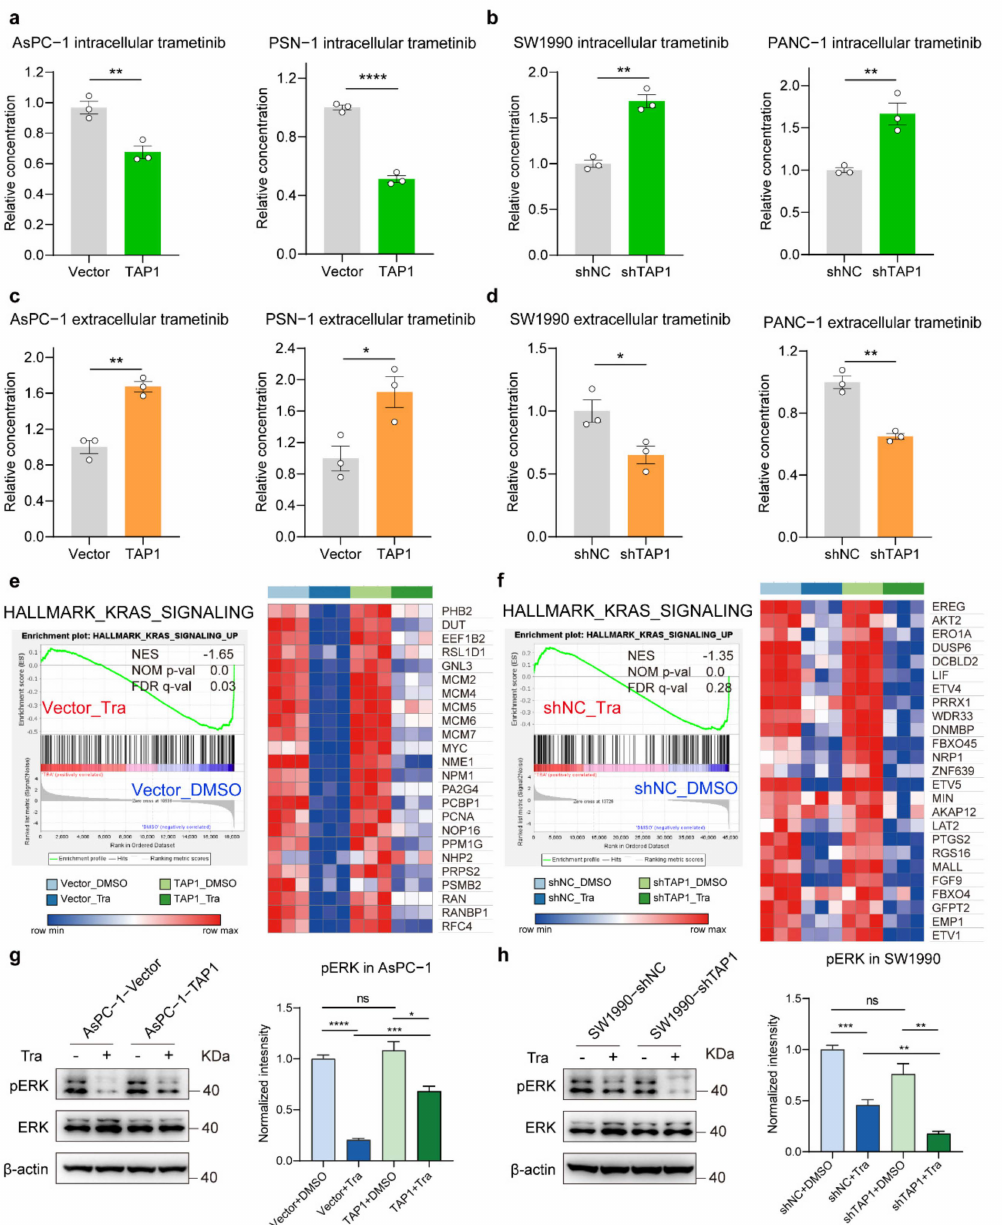
Figure 5. TAP1 (ABCB2) expression promotes the efflux of MEKi and attenuates inhibitory effects in PDAC cells. ( a ) Intracellular drug accumulation after incubation with 1 µ M trametinib in TAP1- overexpressing and their vector control cells were determined by LC-MS/MS. ( b ) Detection of drug accumulation in TAP1-knockdown and their control cells treated by 1 µ M trametinib. ( c , d ) Mea- surement of extracellular trametinib in the cell culture medium of TAP1-overexpressing cells and TAP1-knockdown cells by LC-MS/MS, compared to their respective vector control cells. ( e , f ) Gene set enrichment analysis (GSEA) of genes significantly downregulated in AsPC-1-Vector and SW1990- shNC cells treated by trametinib in comparison with DMSO treatment. The normalized enrichment score (NES), the nominal (NOM) p -value, and the false discovery rate (FDR) q-value are indicated in the insert. At the right, each panel shows a heat map with the core genes of each gene set in